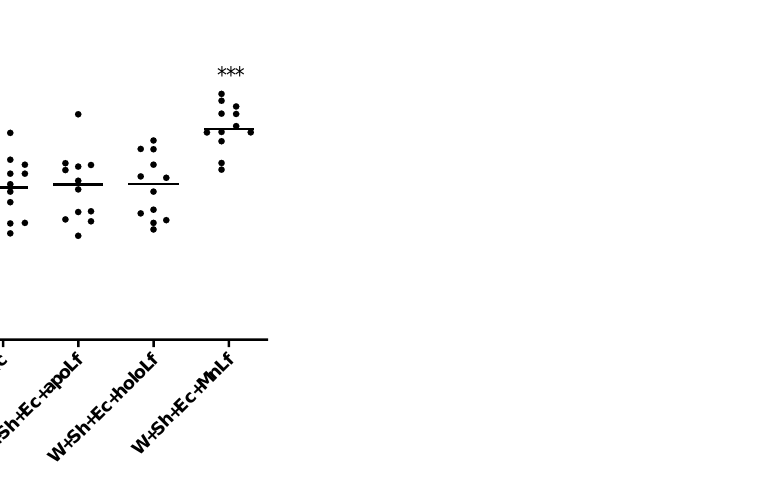
Figure 4. Population numbers of total E. coli for groups with lactoferrin supplementation in blood d. 16 ( A ), blood d. 17 ( B ), spleen ( C ) and feces ( D ). *** p < 0.01 vs. W+Sh+Ec group. W+Sh+Ec-target model group weaned with administration of both intraperitoneal S. haemolyticus 186 and oral E. coli 3A/1. W+Sh+Ec+apoLf-p.o. metal-depleted apoLf, W+Sh+Ec+holoLf-p.o. iron-saturated holoLf, W+Sh+Ec+MnLf-p.o. manganese-saturated MnLf.